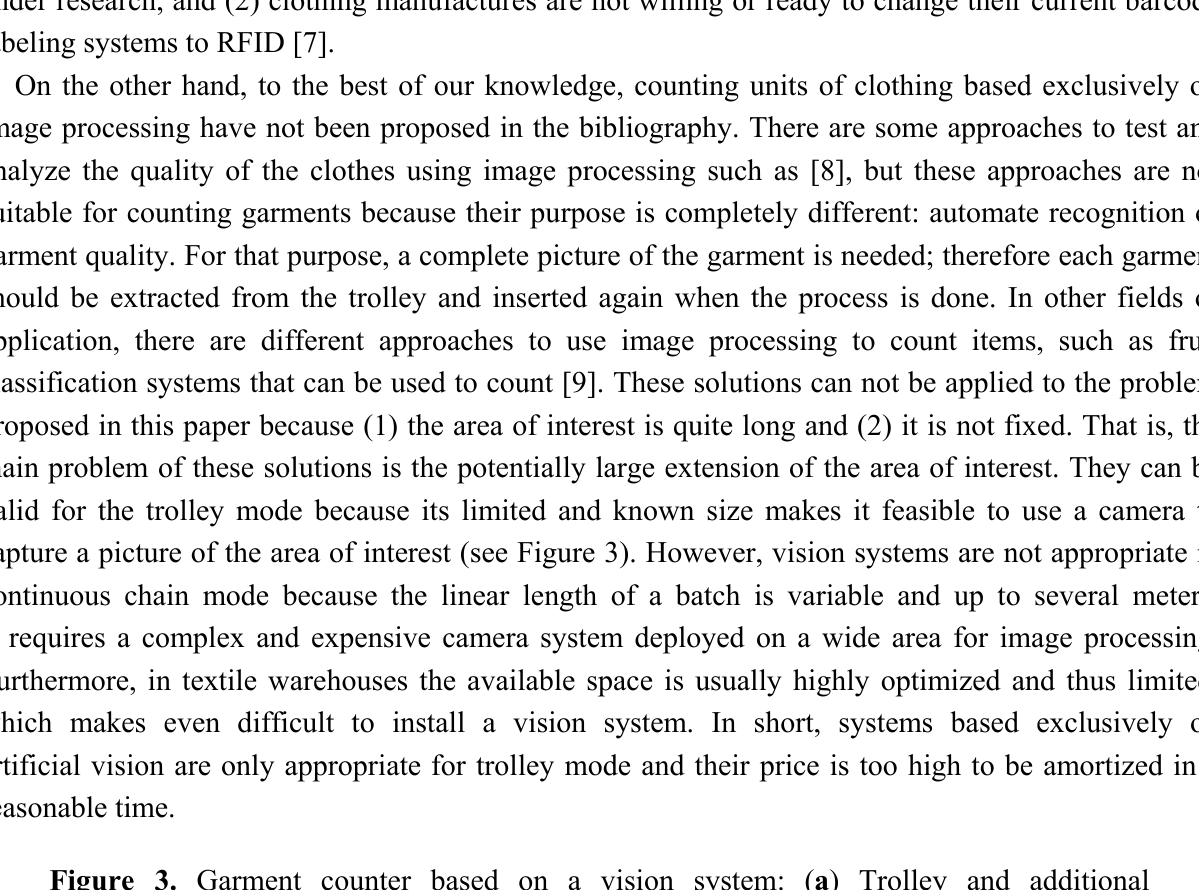
Figure 3. Garment counter based on a vision system: ( a ) Trolley and additional illumination to improve the image acquisition. ( b ) Trolley’s picture from a